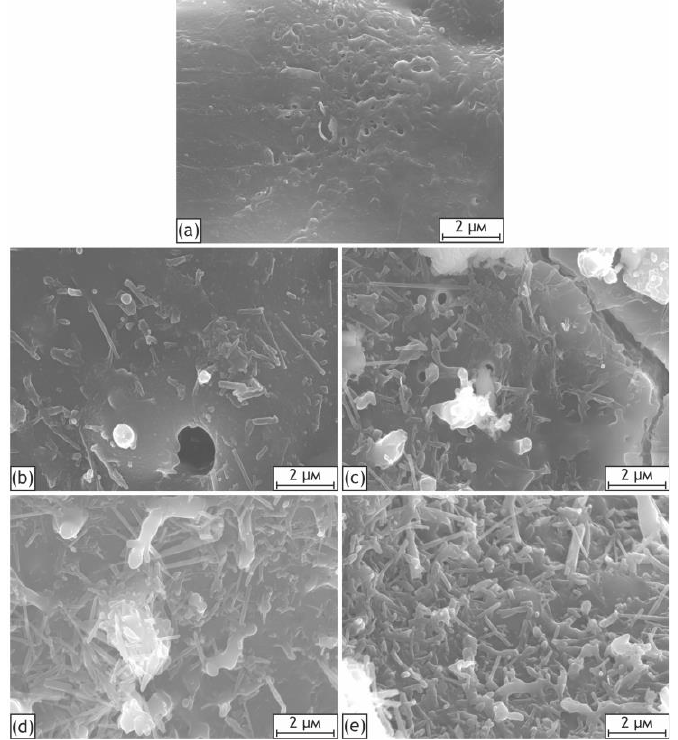
Figure 3. High-magnification SEM images of coatings surface: H0 ( a ), H10 ( b ), H20 ( c ), H30 ( d ), H40 ( e ). More detailed SEM images of the incorporated nanoparticles and agglomerates on the surface of the H40 sample are shown in Figure 4. The red frames within the pictures represent areas that were magnified and analyzed. The incorporated particles retain their characteristic tubular shape under the strong conditions of the PEO process, which positively affects the adsorptive capacity of the HNTs and the formed